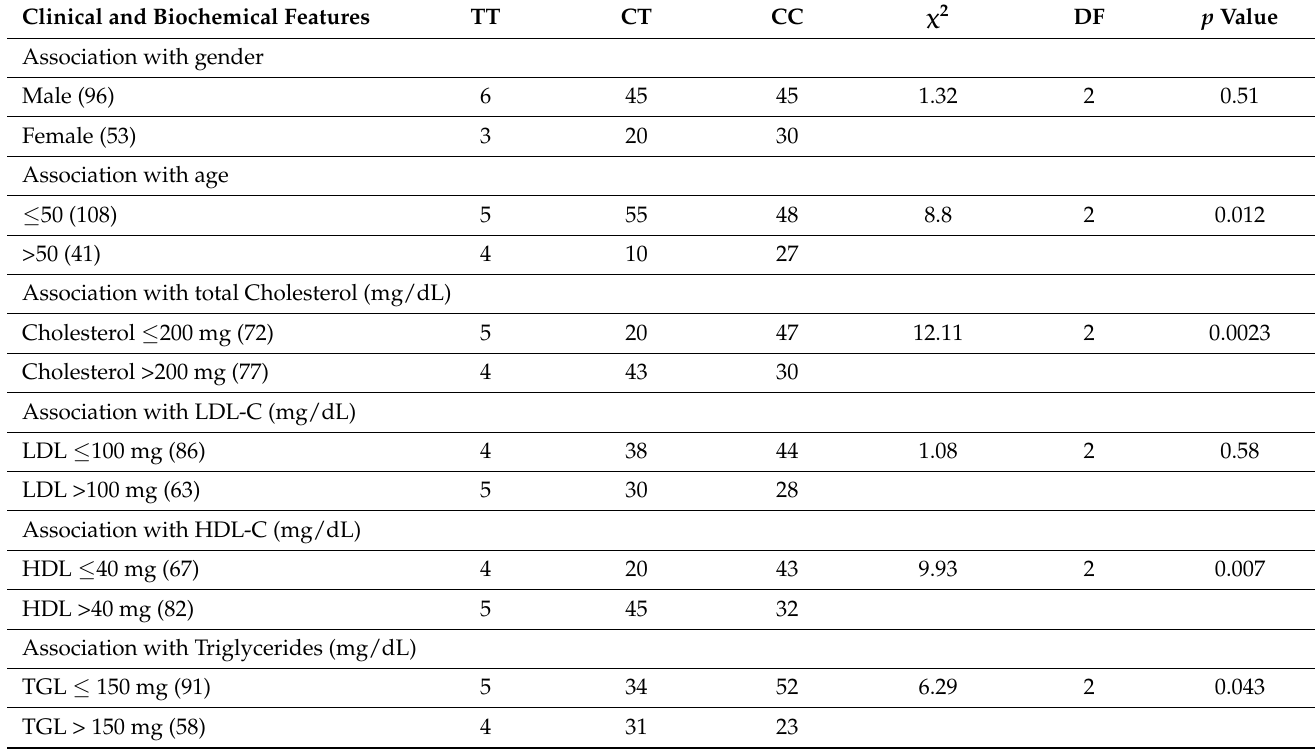
Table 8. Association of clinical and biochemical features of coronary artery disease with ACE2 rs4240157T>C